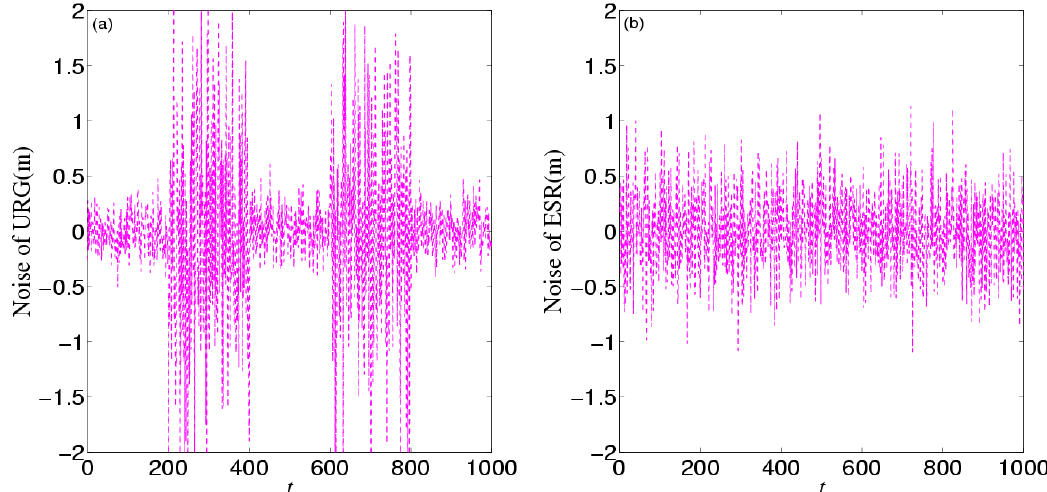
Figure 16. The noise of ( a ) URG and ( b ) ESR in the third experiment.